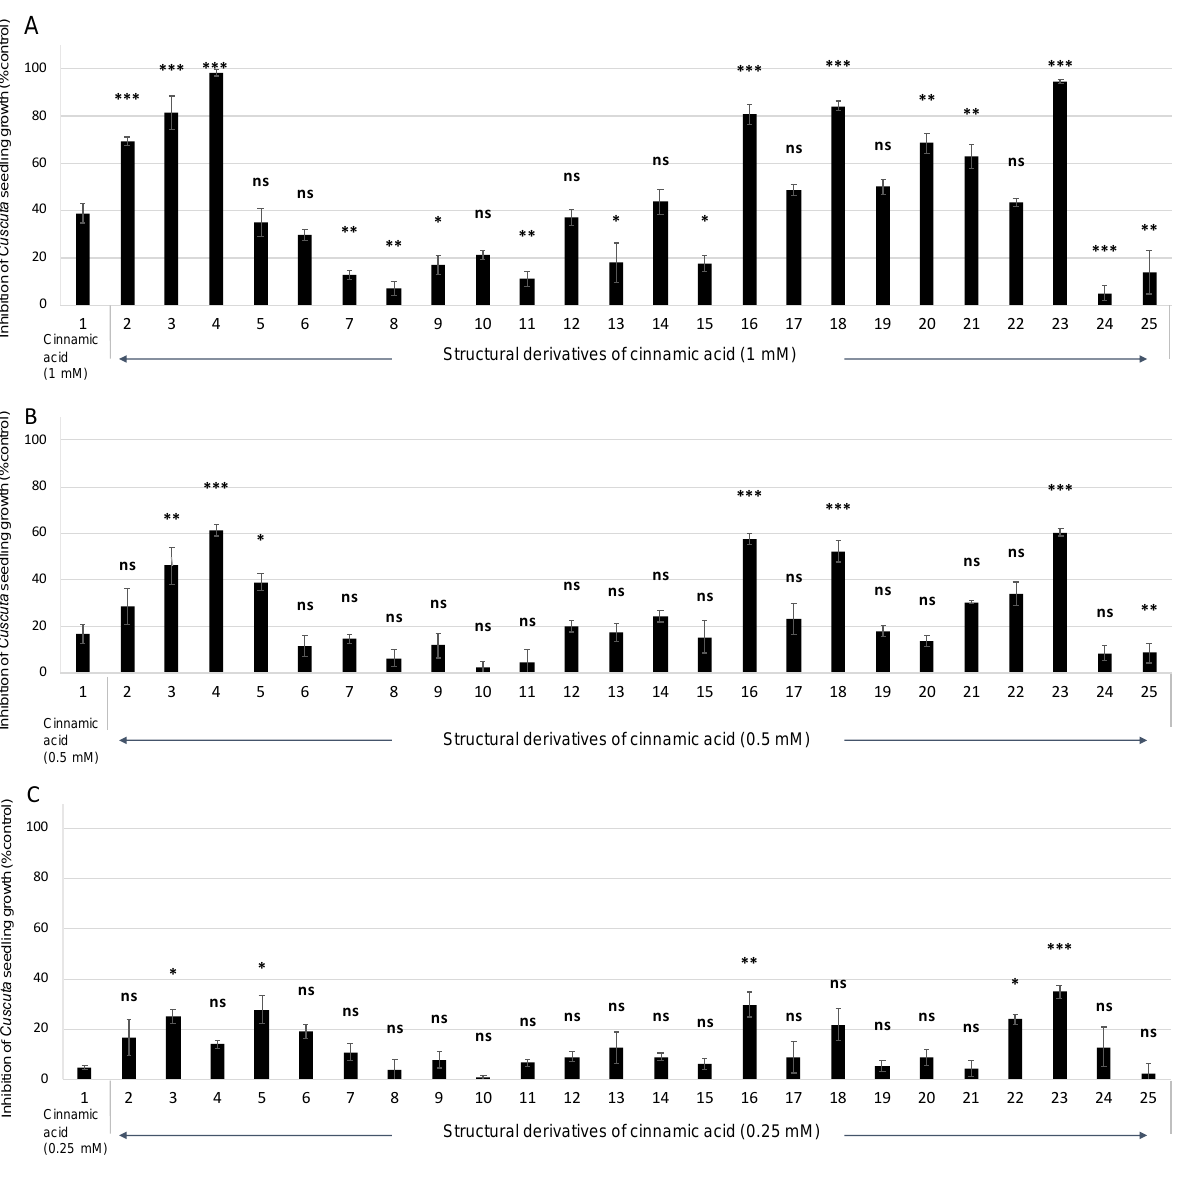
Figure 2. In vitro assessment of the Cuscuta campestris growth inhibition induced by compounds trans -cinnamic acid ( 1 ) and derivatives ( 2 – 25 ) at concentrations of 1 mM ( A ), 0.5 mM ( B ), and 0.25 mM ( C ). Analysis of variance was applied to replicate data, and the C. campestris growth inhibition induced by cinnamic acid and derivatives was assessed by the two-sided Dunnett’s test. For each concentration, *, **, and *** indicate significant differences between each treatment with trans -cinnamic acid ( 1 ) at p < 0.05, 0.01, and 0.001, respectively; ns indicates no significant difference when comparing each treatment with trans -cinnamic acid ( 1 ). Error bars represent the standard error of the mean. The inhibitory activity of derivative compounds with halogenated substituents on the aromatic ring (namely, compounds 18 – 21 ) was increased when compared with trans - cinnamic acid ( 1 ). This finding agrees with a previous study where halogenated